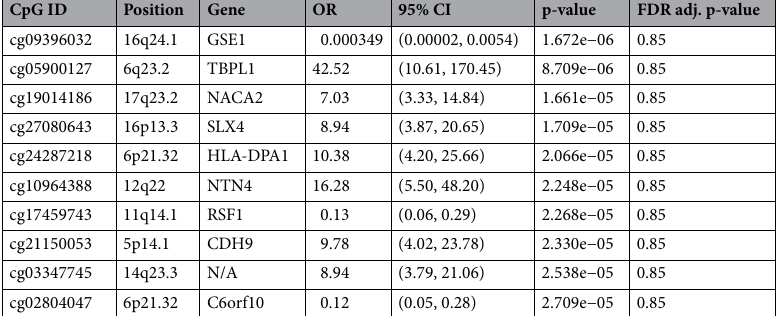
Table 2. The top 10 CpG sites in the conditional logistic regression analyses of CpG sites for melanoma cases (n = 183) versus controls (n = 183). Adjusted for lifetime number of sunburns, hair colour, and the 10 first surrogate variables. OR odds ratio, CI confidence interval, FDR False discovery